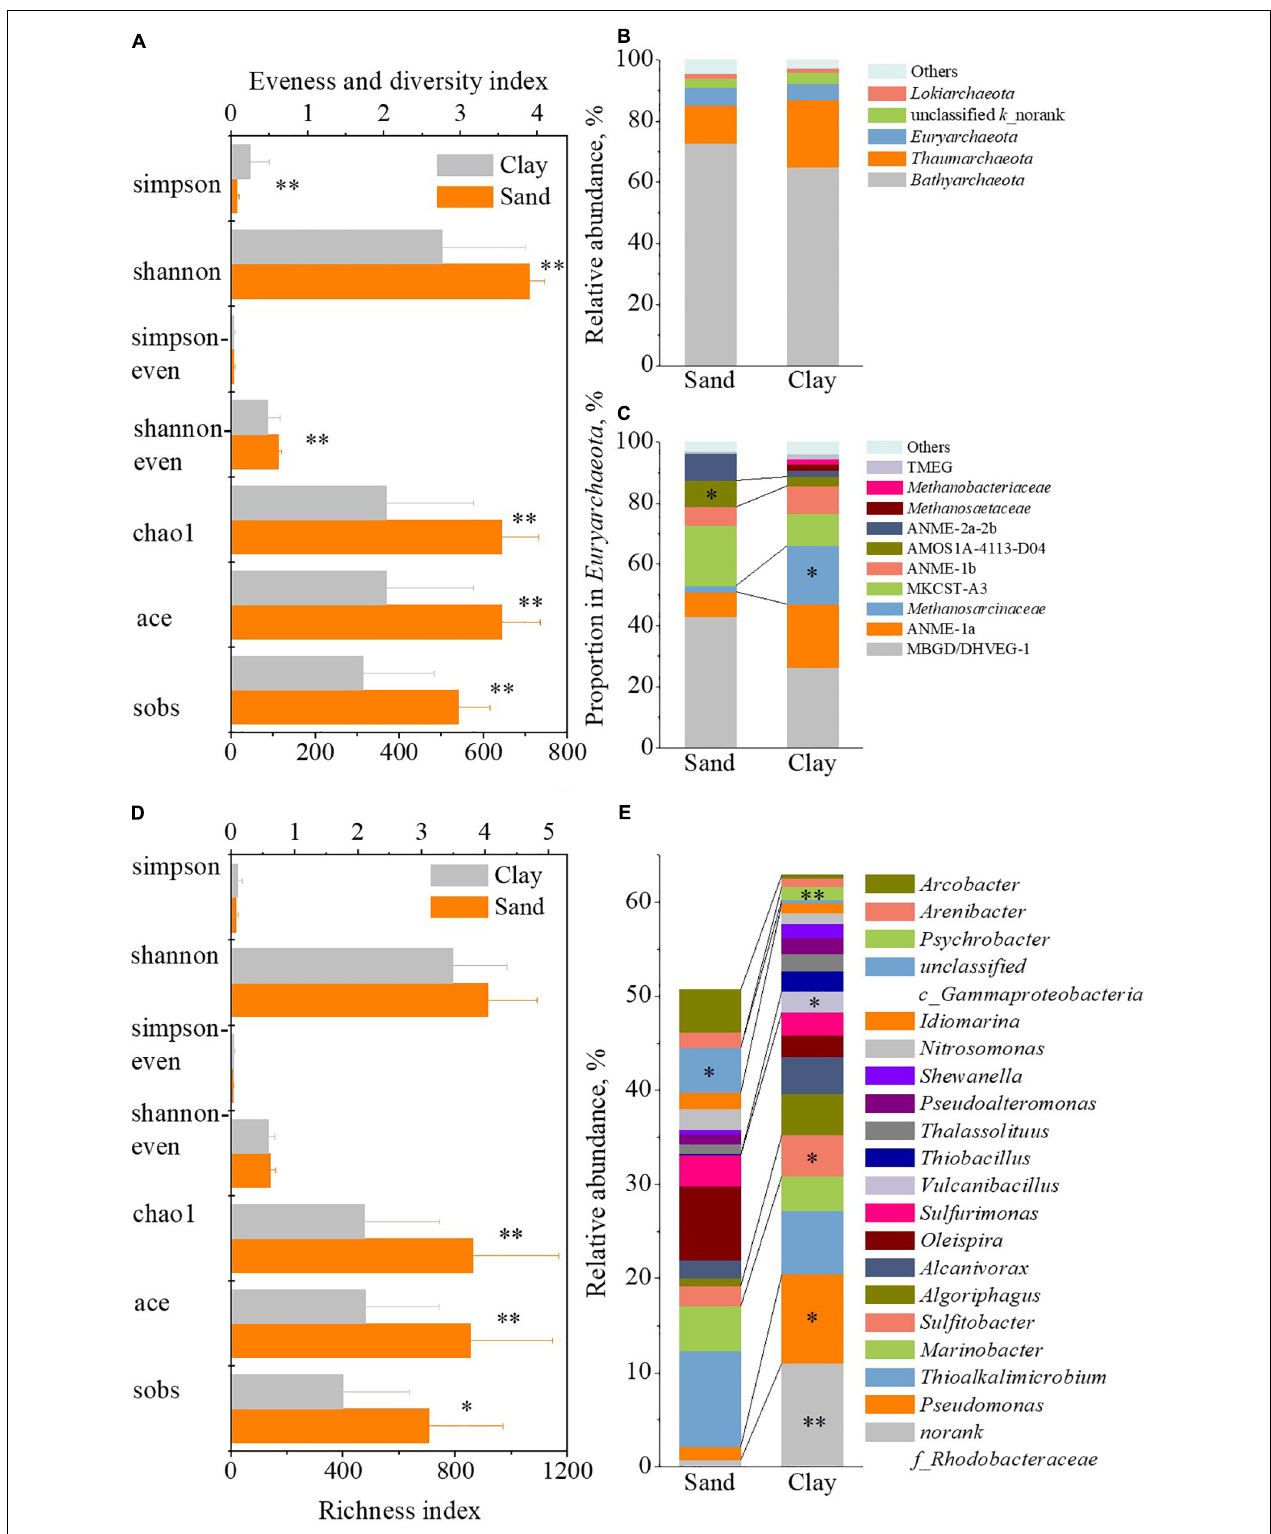
FIGURE 8 | The difference of microbial community between clay strata and sand strata. The difference of α -diversity indexes of archaeal community (A) , relative abundance of archaeal phylum (B) , proportion in Euryarchaeota at family level (C) , α -diversity indexes of bacterial community (D) , and relative abundance of bacterial genus (E) between sand strata and clay